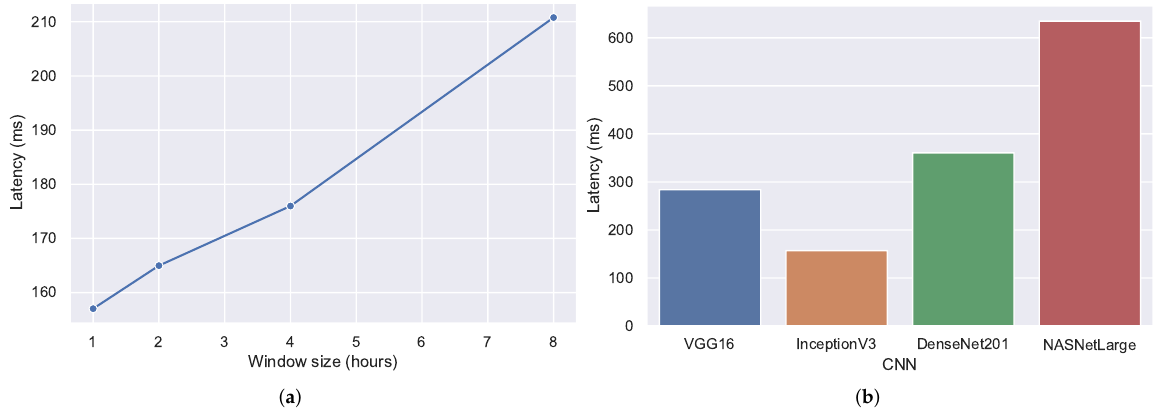
Figure 18. Latency experiments. ( a ) Image latency with different window sizes. ( b ) Latency of each CNN